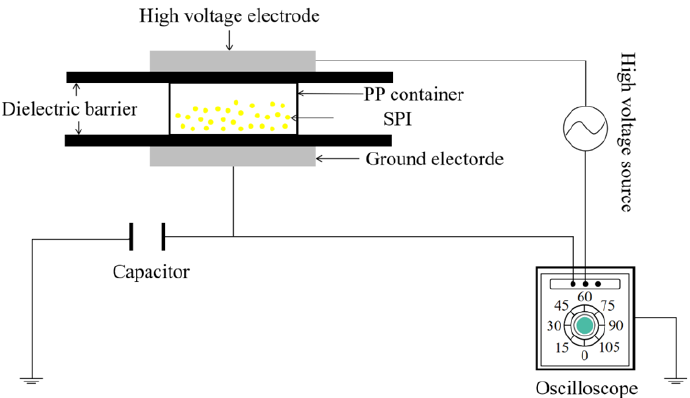
Figure 1. Schematic diagram of experimental equipment for DBD plasma system.